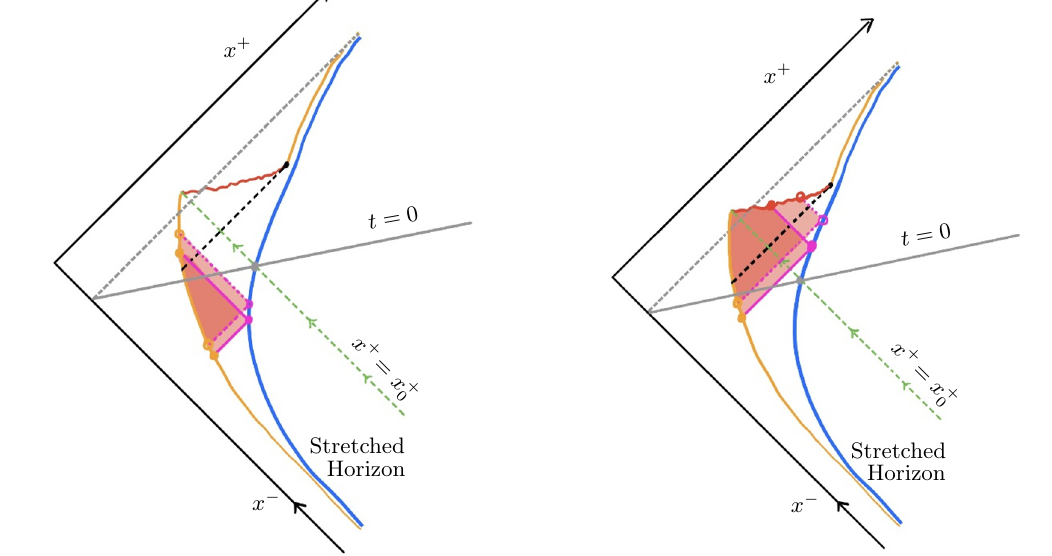
Figure 6 . Kruskal diagrams of evolution of a WdW patch of an evaporating black hole. Color coding coincides with (cid:12)gure